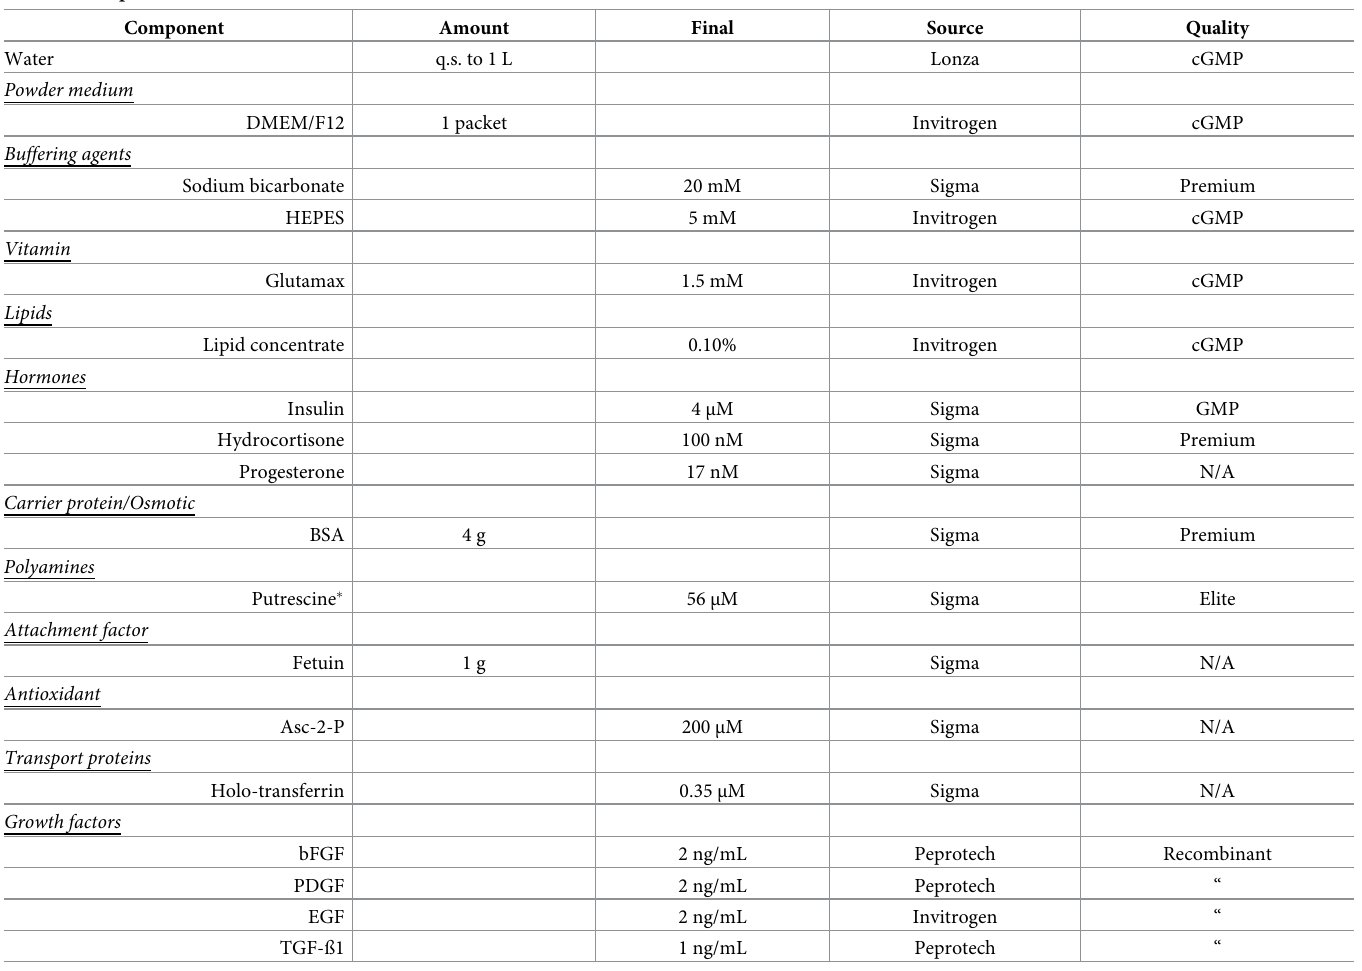
Table 1. Composition of serum-free medium for cultivation of canine